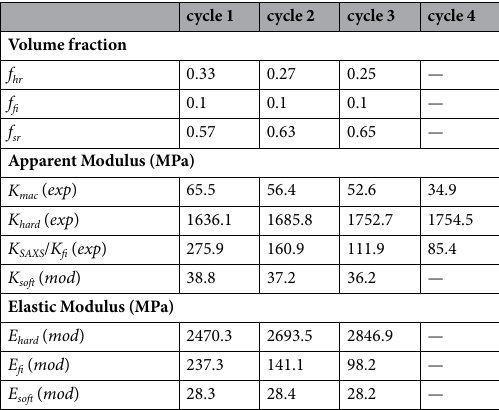
Table 1. Changes of the volume fraction, apparent modulus and elastic modulus of different phases in unload cycles. f hr f fi and f sr refer to the volume fractions of the hard region (HR), fuzzy interface (FI) and soft region (SR); K mac , K hard and K saxs (or K fi ) are experimentally measured ( exp ) macro-, atomic scale and nano-scale apparent moduli. K soft is the apparent modulus obtained from the refined model ( mod ) for pure soft region; E hard , E fi and E soft are the refined ( mod ) elastic moduli for each